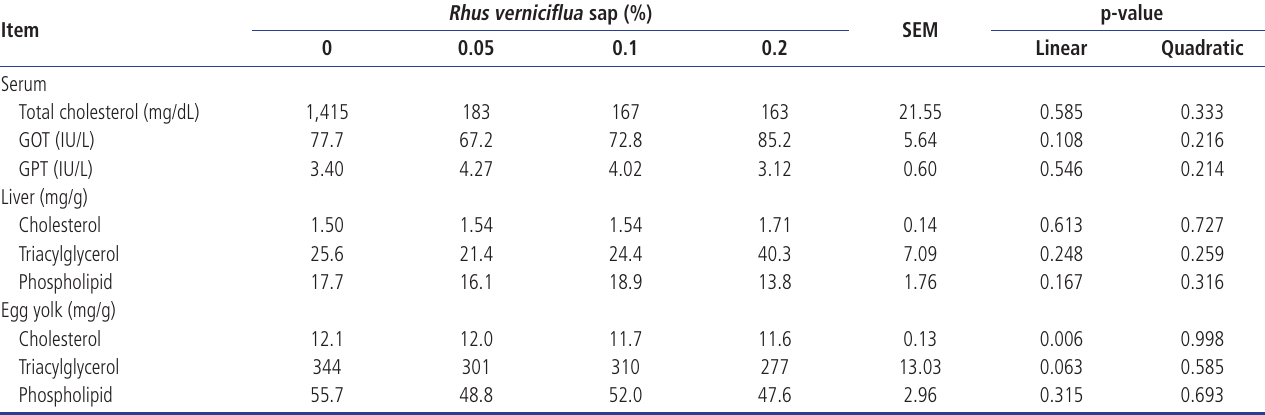
Table 4. Effect of dietary detoxified Rhus verniciflua sap on blood profiles and lipid fractions of liver and egg yolk in laying hens